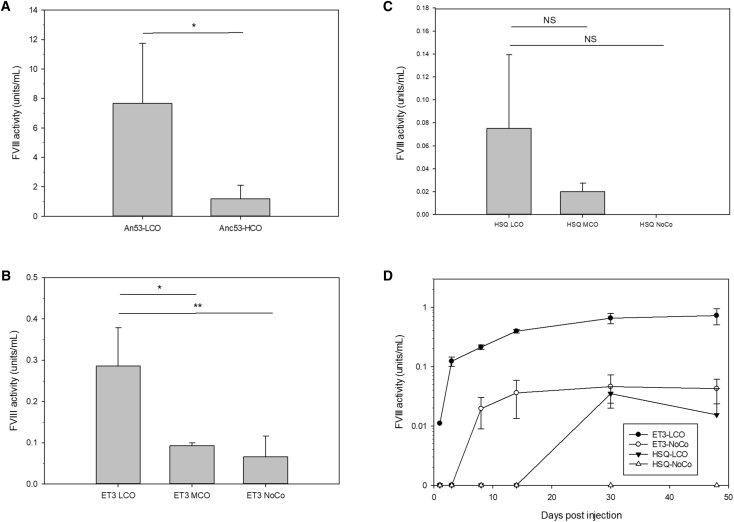
In Vivo Expression of Codon-Optimized Designs(A–C) Shown here: (A) An53-HCO and An53-LCO; (B) ET3-LCO, ET3-MCO, and ET3-NoCo; and (C) HSQ-LCO, HSQ-MCO, and HSQ-NoCo plasmids were hydrodynamically injected into hemophilia A mice (n = 3–4 for all groups). Plasma levels of fVIII activity were measured 24 hr after transfection. In (A), *p < 0.05 by two-tailed t test, and in (B), *p = 0.05 and **p = 0.004 by one-way ANOVA and the Holm-Sidak method. NS, not significant. (D) Linearized ET3 and HSQ-LCO and NoCo were hydrodynamically injected into hemophilia A mice. Plasma levels of fVIII activity were measured for 6 weeks post-injection. Data are presented as the mean ± sample SD.